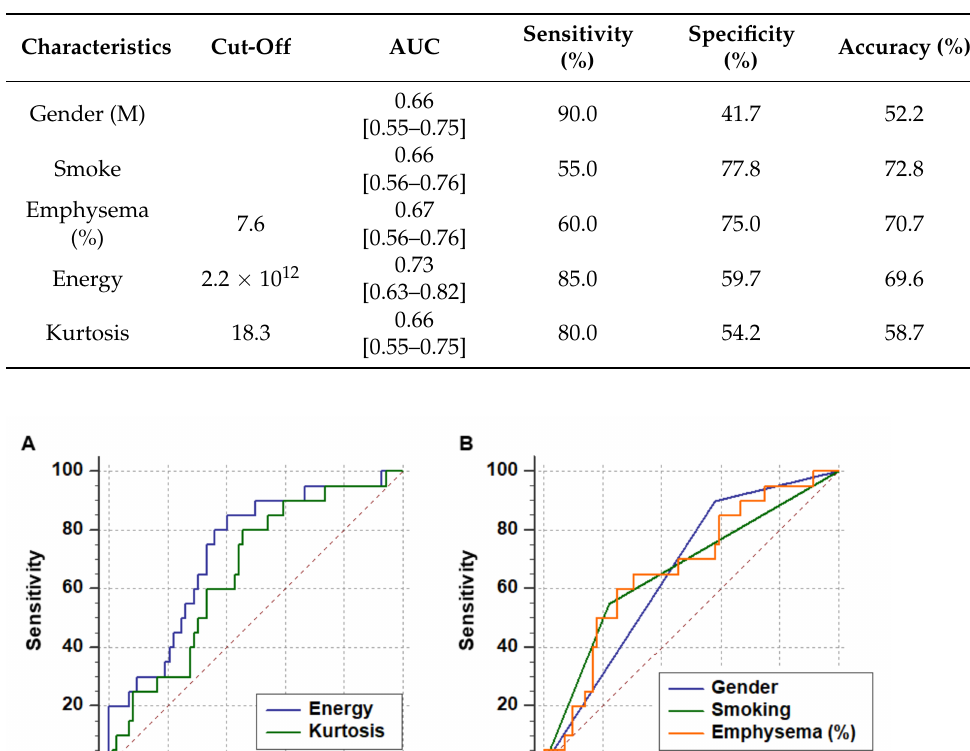
Table 4. Diagnostic accuracy based on gender, smoke, emphysema (%), and radiomics features in the training cohort.